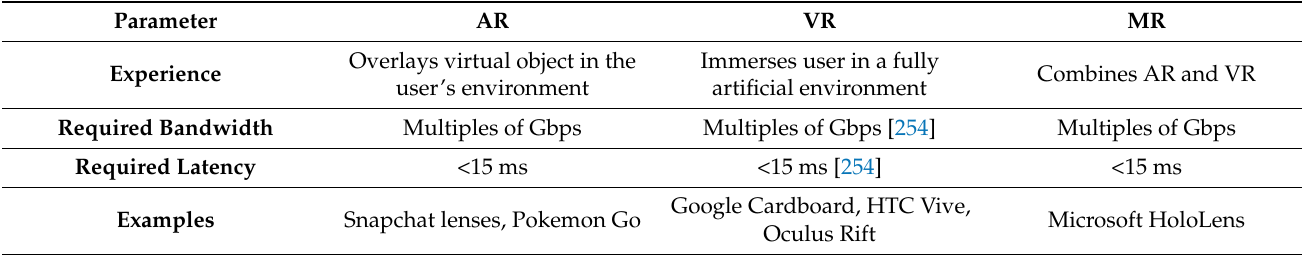
Table 16. Comparing AR, VR, and